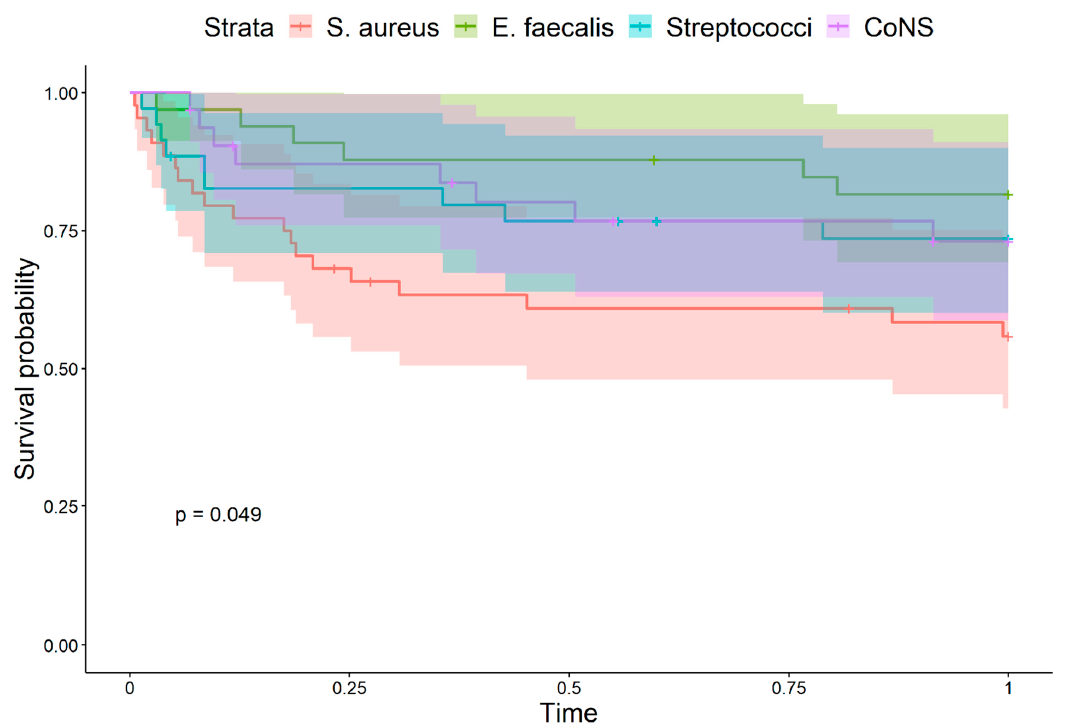
Figure 1. Kaplan–Meier 1-year survival curves when comparing IE groups presented with different causative microorganisms. p -Value represents the overall differences.